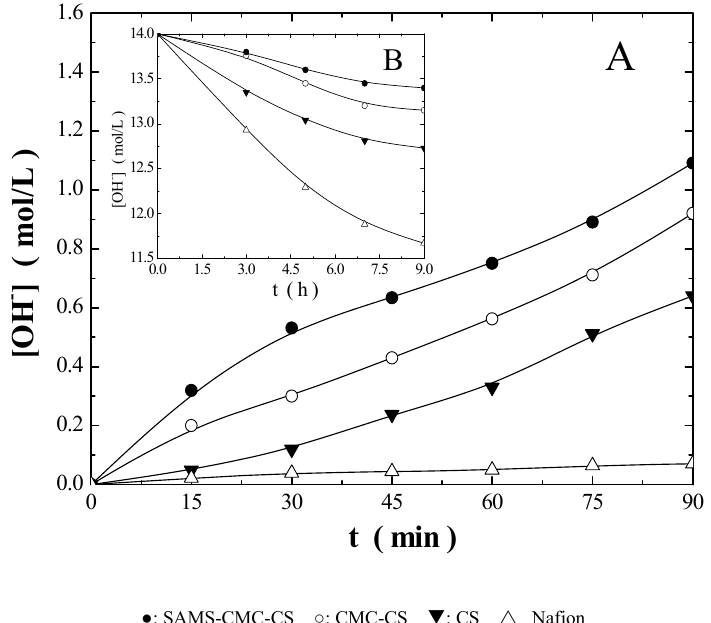
Fig. 8 Changes of concentration of OH − in anode chamber at J=20 mA/cm 2 as a function of time Insert: Changes of concentration of OH- in anode chamber at J=20 mA/cm2 during the electro-generated of FeO 42 −